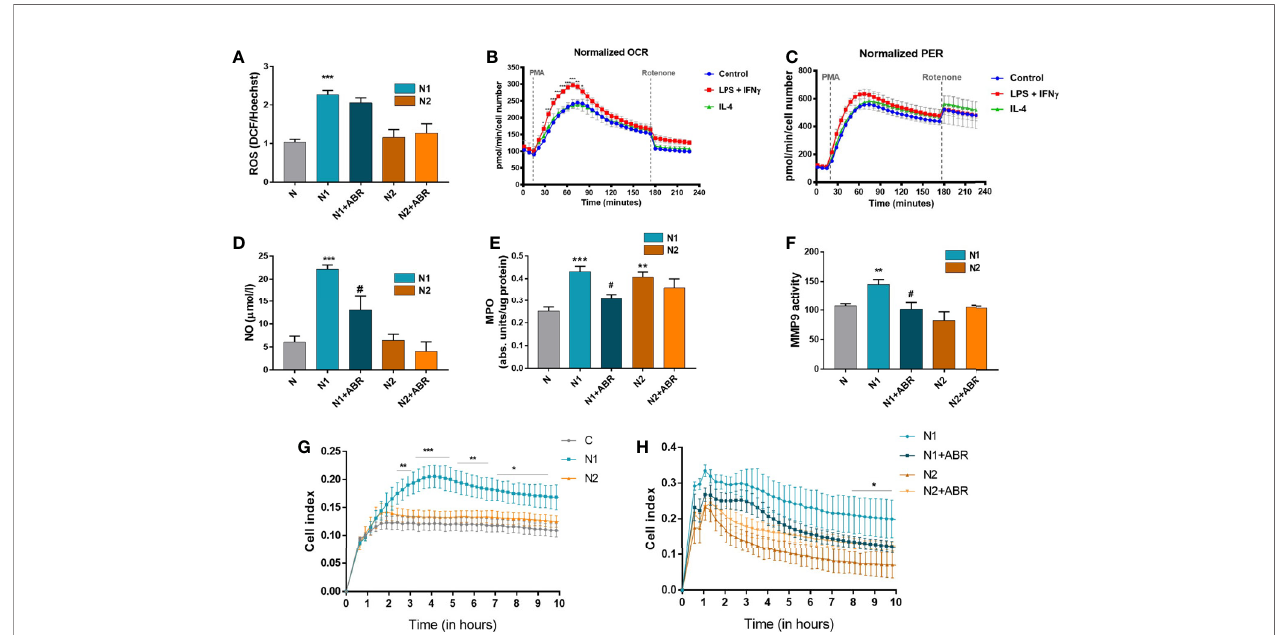
FIGURE 5 | Functionalanalysisofneutrophilpopulations. The cells were treatedfor 18h with LPS + IFN g (N1) or IL-4 (N2)in the presence orabsence of ABR-238901 (ABR). (A) Quanti fi cation of intracellular ROS usingthe DCFDA assay. (B, C) Measurement of the neutrophiloxidative burst evaluated inresponse to phorbol 12-myristate 13-acetate (PMA): (B) theoxygen consumption rate (OCR) and (C) the glycolyticproton ef fl uxrate (PER), calculated using extracellular acidi fi cation rate (ECAR) measurements. (D) Quanti fi cation of NO releasedin the conditioned mediumofneutrophil subtypes. (E) evaluation of MPO enzymaticactivity inthe cell lysate of neutrophil populations. (F) Quanti fi cation of MMP-9 gelatinase activity assessedby SDS ‐ PAGE zymography in the condition media of neutrophils. (G,H) The chemotactic activity of neutrophilpopulationstoward IL-8 evaluated usinga CIM-plate 16 and the xCELLigence RTCA DPsystem.The cell index (CI),proportional to the number of transmigrated neutrophils, was measured as the cell electrical impedance every 15 min over 10h.Data arefromfourindependent experiments; every experiment usedpooled neutrophils from at least5 mice. Dataare shownas mean foldchange to control ± SE (n= 4).Statisticalsigni fi cance isshown as *p< 0.05, **p < 0.01, ***p < 0.001, # p ≤